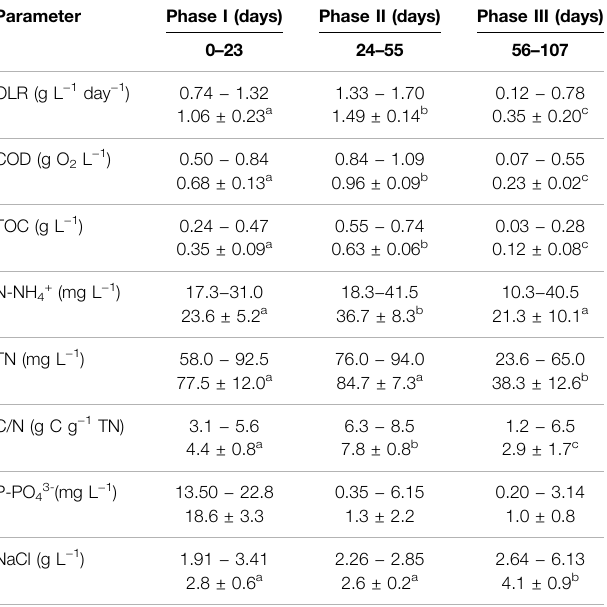
TABLE 1 | Fish canning wastewater characterization throughout the reactor operation; minimum and maximum values and average ± standard deviation values are